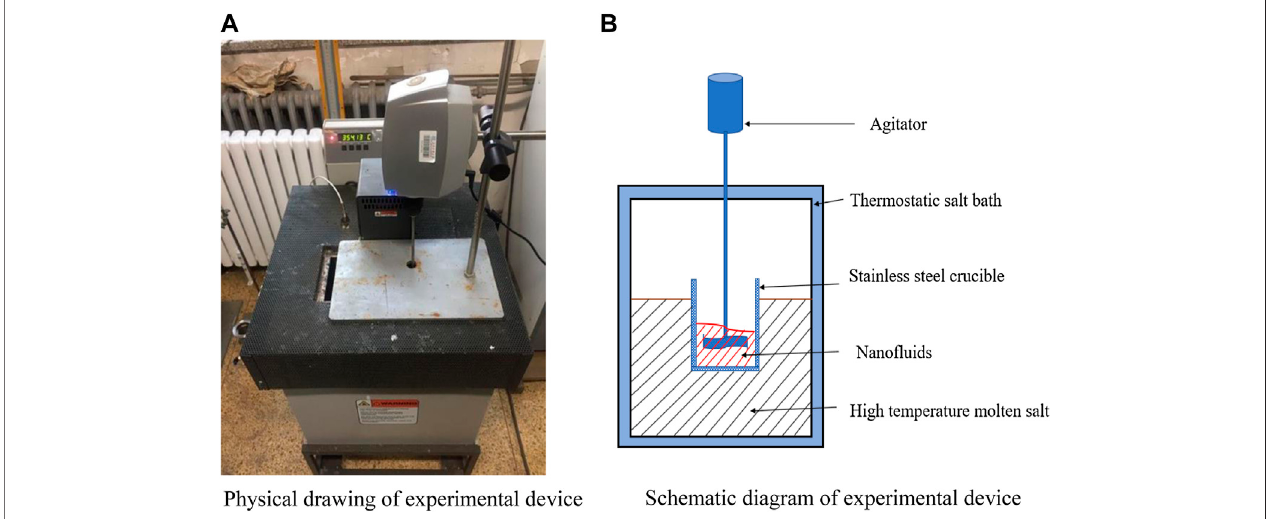
FIGURE 1 | Experimental picture and schematic diagram for the nano fl uid preparation. (A) Physical drawing of experimental device. (B) Schematic diagram of experimental device.